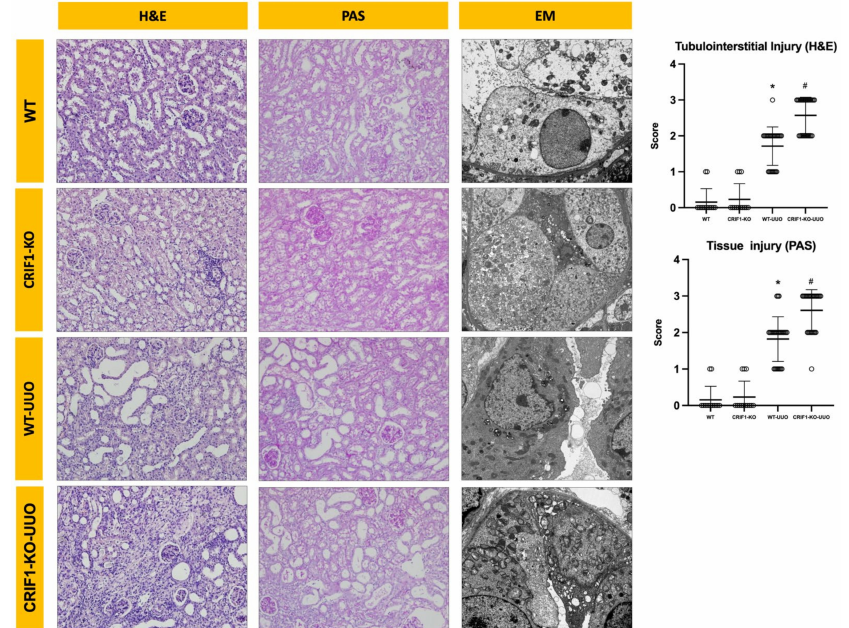
Figure 5. Photos of hematoxylin and eosin, periodic acid–Schiff stains, and electron microscopy of wild-type (WT) and CR6-interacting factor-1 knockout (CRIF1-KO) mouse kidneys. WT-unilateral ureteral obstruction (UUO) kidneys showed an increase in tubular injury score compared with non-UUO kidneys. CRIF1-KO-UUO kidneys showed an increase in tubular injury score compared with WT-UUO kidneys. Although CRIF1-KO kidneys showed severe mitochondrial injury, UUO did not significantly alter the mitochondrial morphology in WT kidneys. * p < 0.05, WT-sham vs. WT-UUO; # p < 0.05, WT-UUO vs.